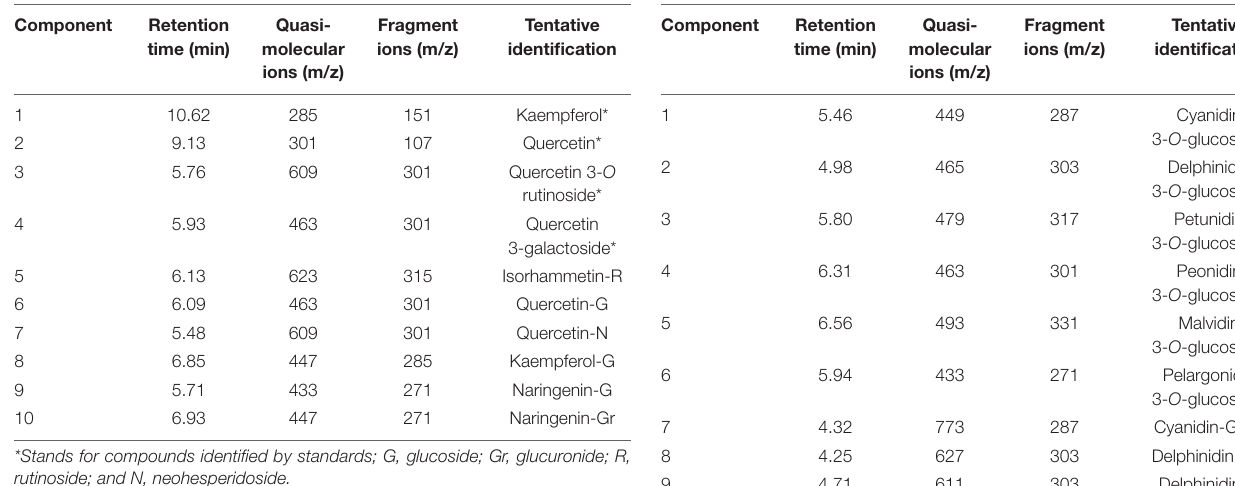
TABLE 1 | Identification of anthoxanthins component from Freesia hybrida petals. TABLE 2 | Identification of anthocyanins component from Freesia hybrida petals.